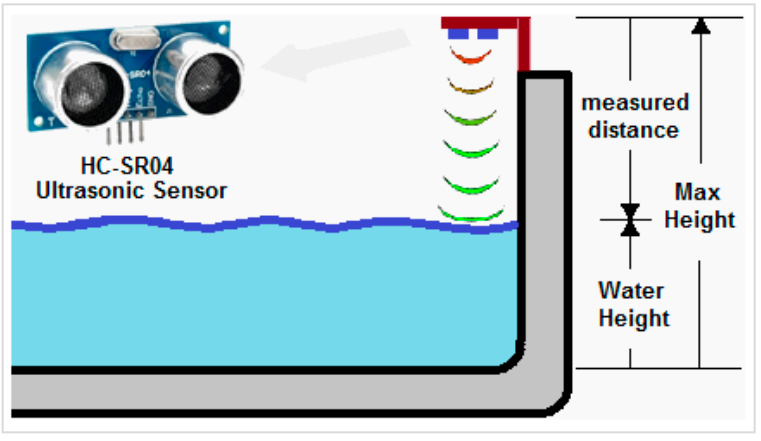
Figure 8. The HC-SR04 sensor used to measure the water level.